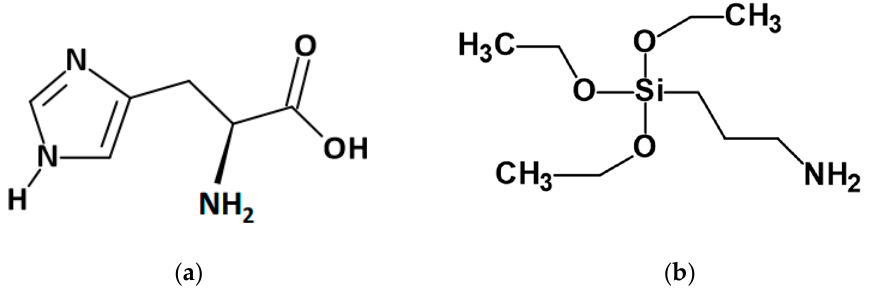
Figure 1. The chemical structure of histidine ( a ) and 3-Aminopropyltriethoxysilane ( b ). The other chemicals were used for graphene oxide synthesis and modification. The flake graphite was purchased from Asbury Carbons (Asbury, NJ, USA). Sulphuric acid (H 2 SO 4 ), potassium permanganate (KMnO 4 ), potassium nitrate (KNO 3 ), perhydrol (30% H 2 O 2 ), and ethanol (96%) were purchased from Chempur (Piekary ´Sl ˛askie, Poland). All these reagents were pure for analysis. Additionally, 98% APTES (3-Aminopropyltriethoxysilane) was delivered from Alfa Aesar (Haverhill, MA, USA). The APTES structure is present in Figure 1b.